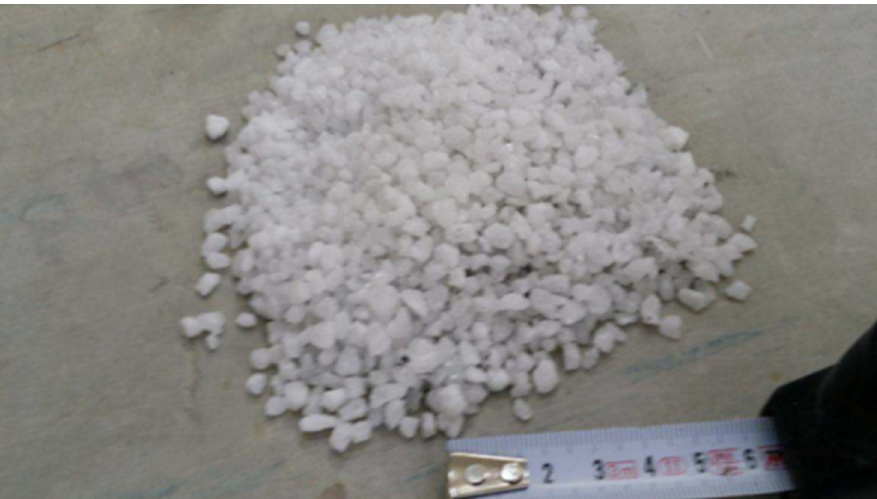
Figure 1. Artificial white corundum fraction 3–5 mm.